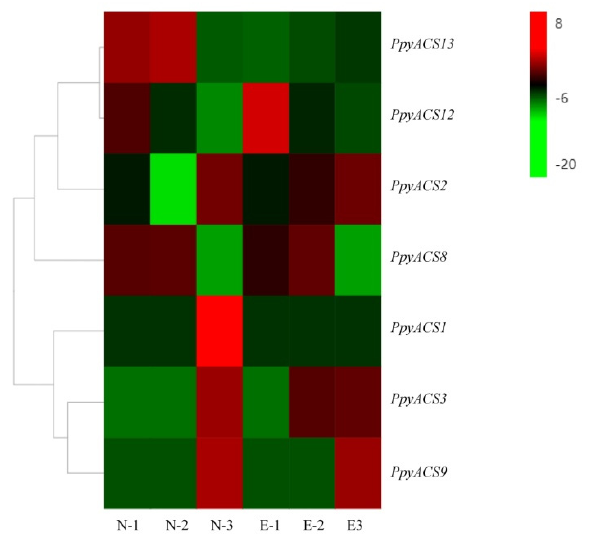
Figure 6. Heat map of the expression level of PpyACSs in fruit ripening. ‘Ninomiyahakuri’ and ‘Eli No. 2’ in three ripening stages, including 1 (pre-ripening, 30 days before harvest), 2 (at harvest) and 3 (fruit senescence, 10 days after harvest). A cluster dendrogram is shown on the left. ACSs are divided into two major groups based on their expression. The color key at the top right corner represents the Z-score values transformed from log2-based expression values obtained by RNA-seq (Table S6).